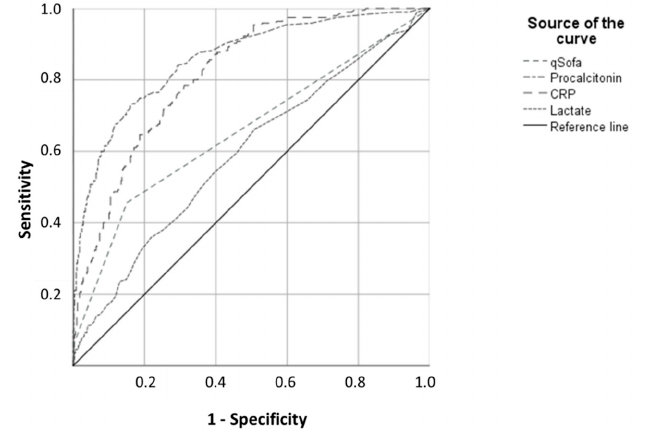
Figure 1. ROC of qSOFA and laboratory parameters for the prediction of sepsis within 96 h of admission. the optimized cut-off value according to ROC-analysis for PCT is 0.26 µG/L. Abbreviations: CRP—C-reactive protein; PCT—procalcitonin. qSOFA—the quick Sequential Organ Failure Assessment.